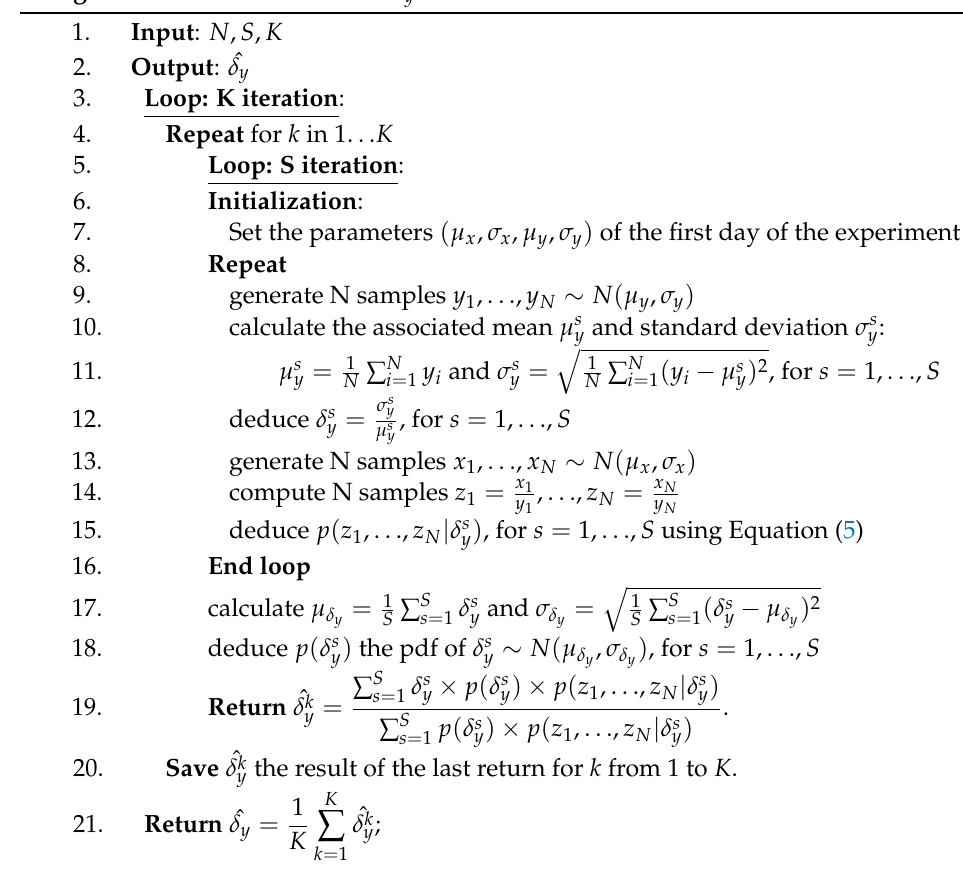
Algorithm 1: MC estimation of δ y